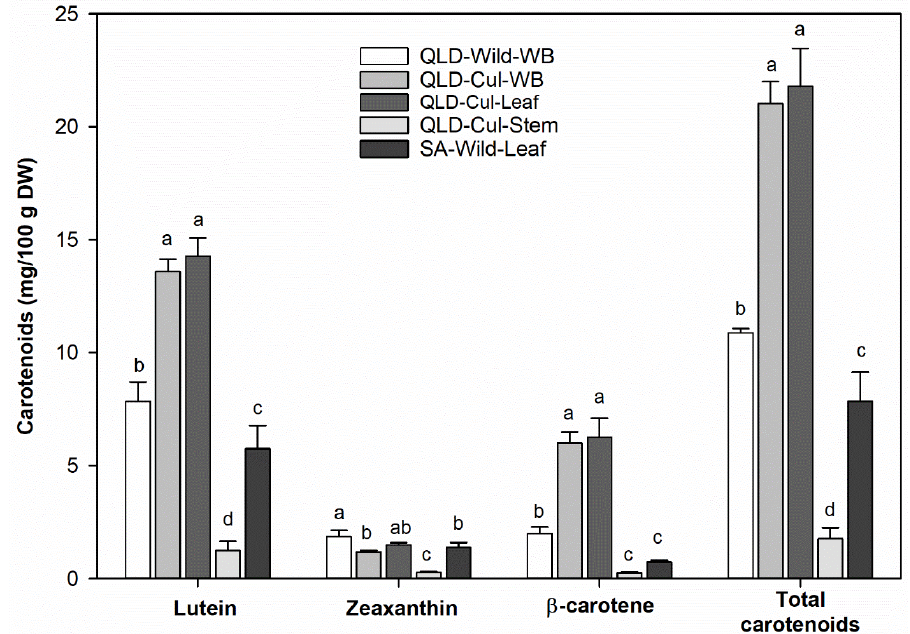
Figure 4. Carotenoids identified in the studied P. angustifolium samples. Data present means ± SD ( n = 3); Different letters of individual carotenoid compounds indicate significant differences at α = 0.05.